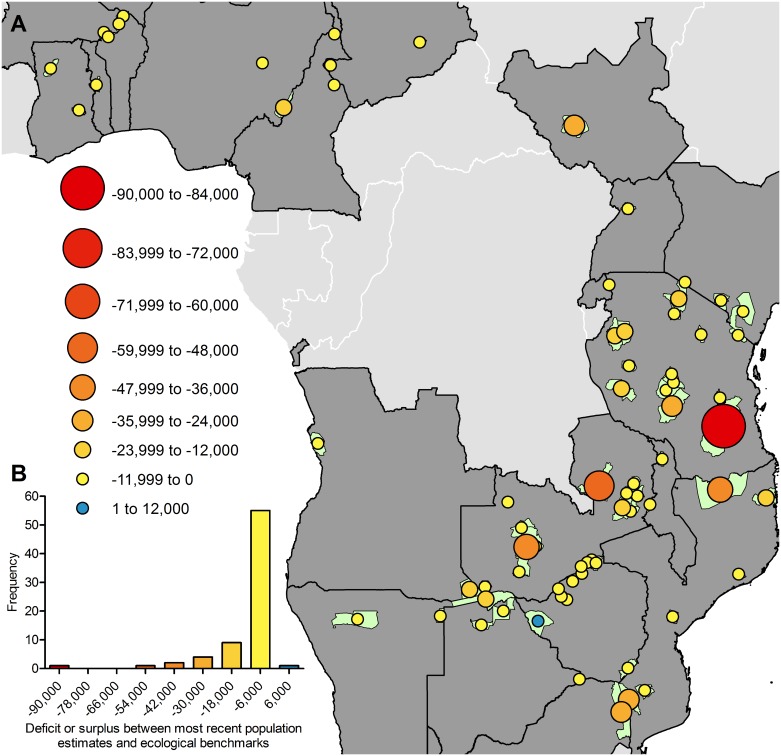
Of 73 protected areas assessed, 72 had a deficit of elephants compared to ecological benchmarks.(A) Subtracting predicted ecological benchmark population size from corresponding recent population estimates yields deficit or surplus estimates for each protected area, illustrated by size and color of circles (net deficit = 729,505). (B) A frequency distribution, where x-axis represents bin centers, illustrates that few populations have large deficits, while most are missing fewer than 12,000 elephants. See Table F in S1 File for the 95% prediction intervals of population deficits/surpluses.